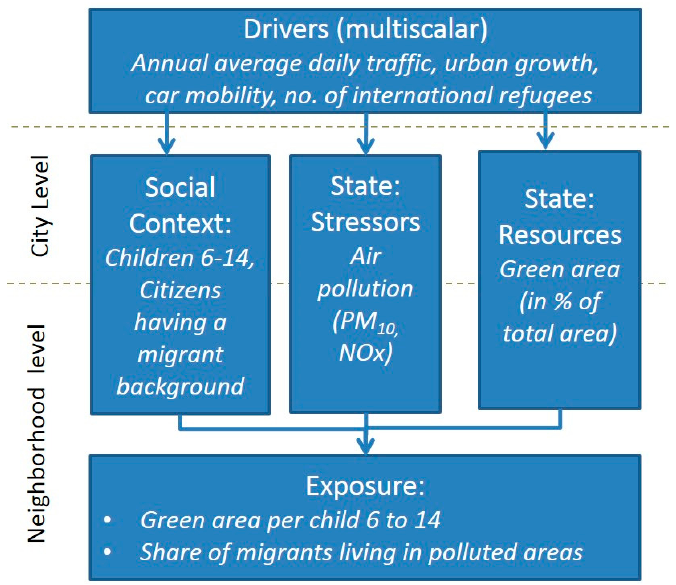
Figure 1. Spatial Urban Health Equity Indicator Framework (SUHEI) (after [33]).